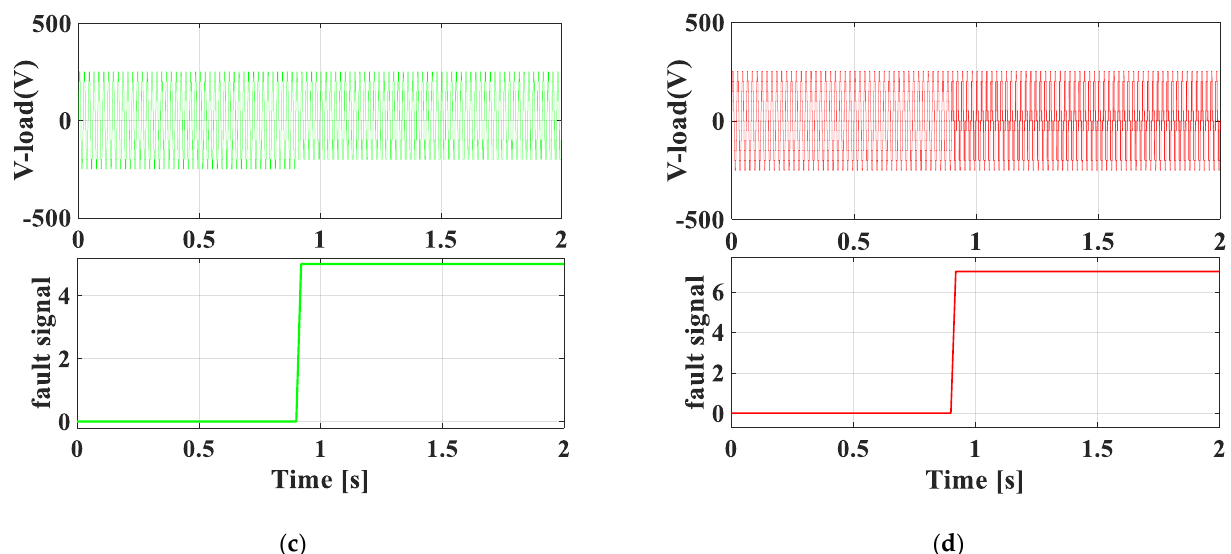
Figure 13. Fault detection simulation results. ( a ) S 1 fault ( b ) S 3 fault ( c ) S 5 fault ( d ) S 7 fault.